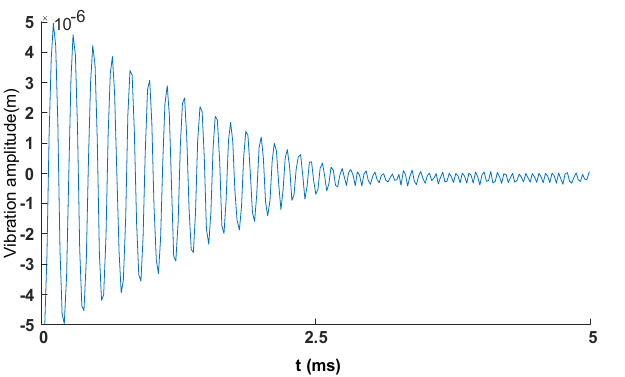
Figure 7. Vibration Propagation of Tool A. ( a ) Time domain transfer characteristic and ( b ) frequency domain transfer characteristics.